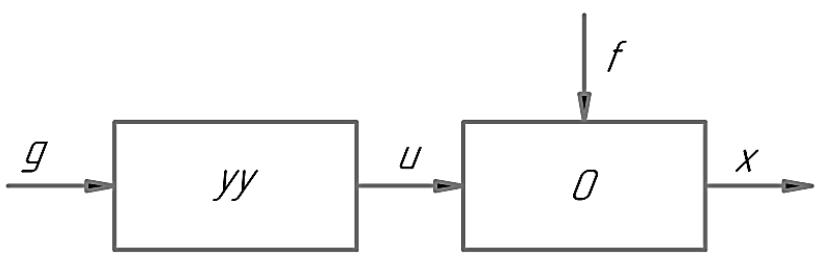
Figure 7. Functional diagram of the automatic control system: yy —control device; and O —control object.